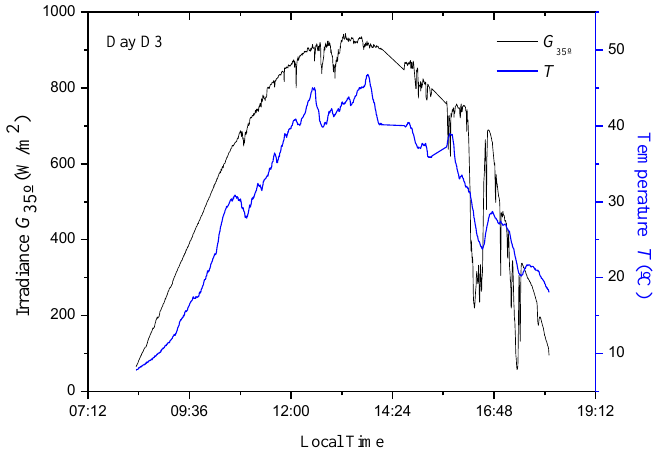
Figure 2. T and G 35° values in the PVG for D2 day.